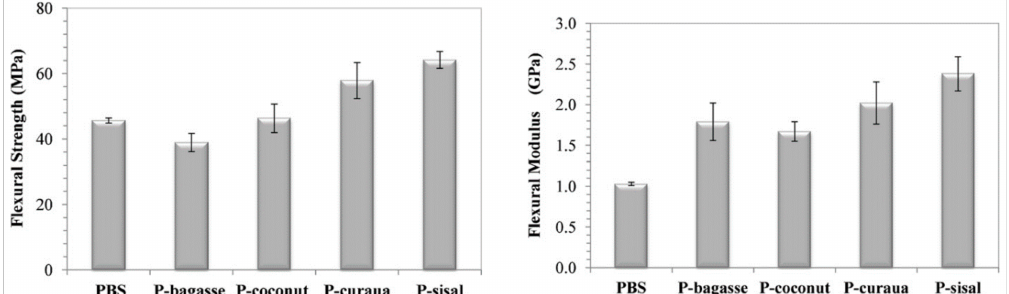
Figure 18. Flexural strength and modulus of PBS and its natural fiber-reinforced composites. Reprinted with permission from the publisher